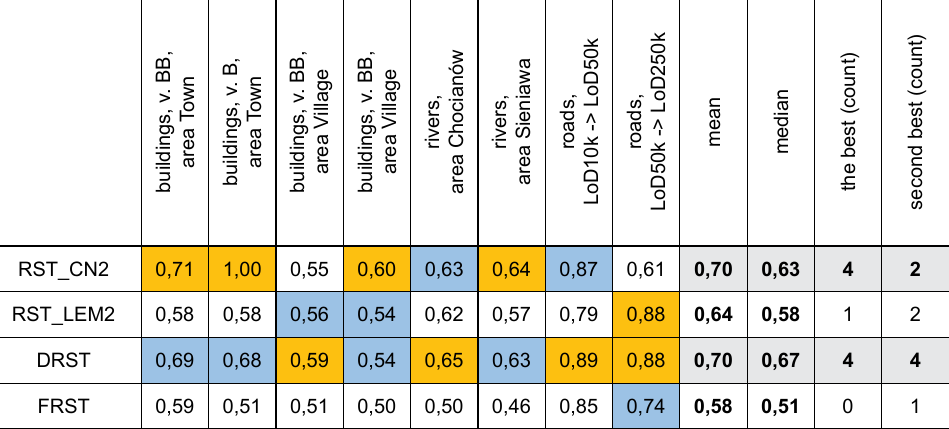
Table 5. The Gini coefficient for results using real data together with its average and median as well as the first (yellow) and second (blue) place achieved by particular methods (source: A. Fiedukowicz 2017)